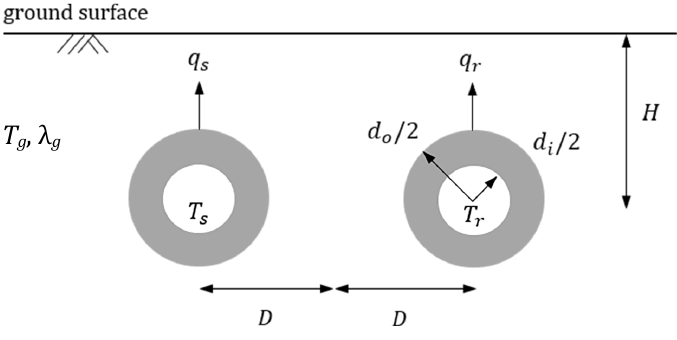
Fig. 2. Geometry of two insulated pipes in the